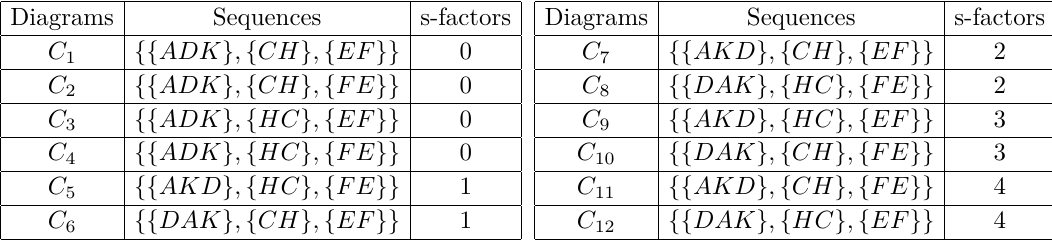
Table 21. Normal ordered diagrams of Cweb W (4)